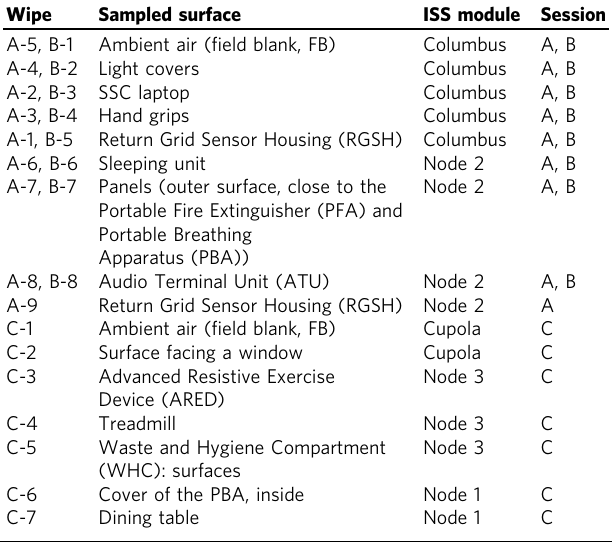
Table 1 Sampling locations and sampling sessions. In total, 24 wipes were retrieved from 5 different modules, and 15 different locations within the